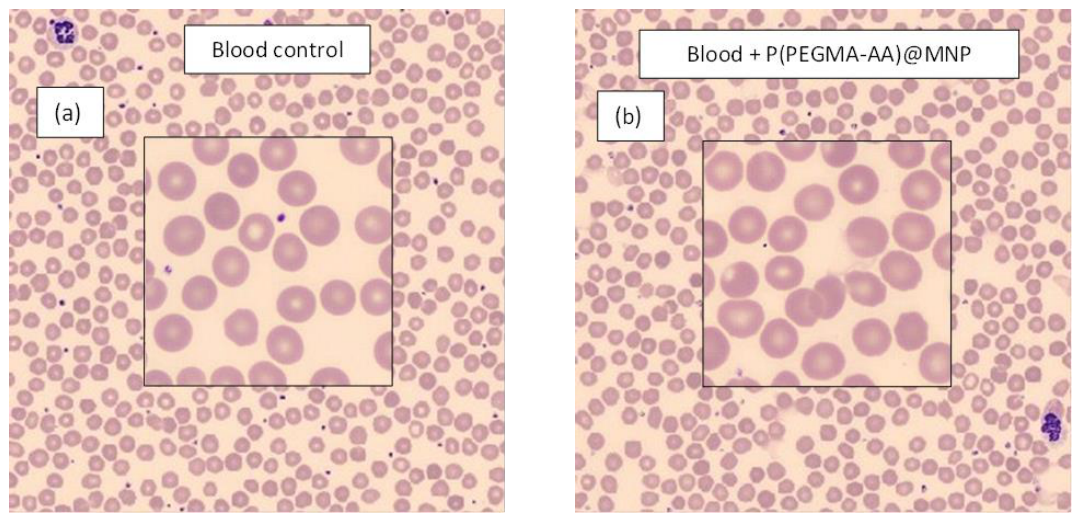
Figure 8. Whole blood smears from the sample of Donor #1 without ( a ) and with ( b ) P(PEGMA-AA)@MNP added at 0.4 mg/mL concentration. The plasma of the two samples are seen in the insets. Small dots in the magnified regions are thrombocytes. The nanoparticles are invisible at the magnification of the optical microscope.